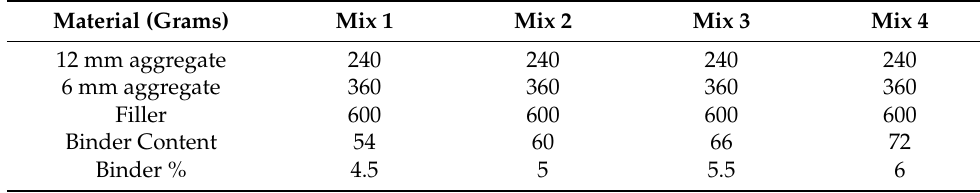
Table 4. Control Mix